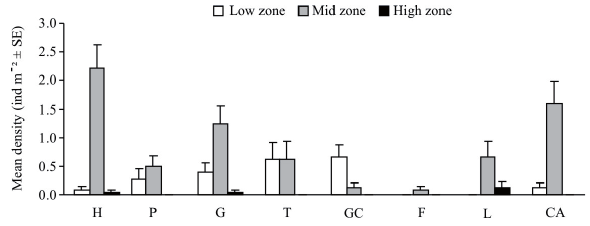
Fig . 2. − mean densities of Stramonita haemastoma in each intertid- al zone across the canarian archipelago. H: el Hierro, P: La Palma, G: La Gomera, T: Tenerife, Gc: Gran canaria, F: Fuerteventura, L: Lanzarote, ca: chinijo